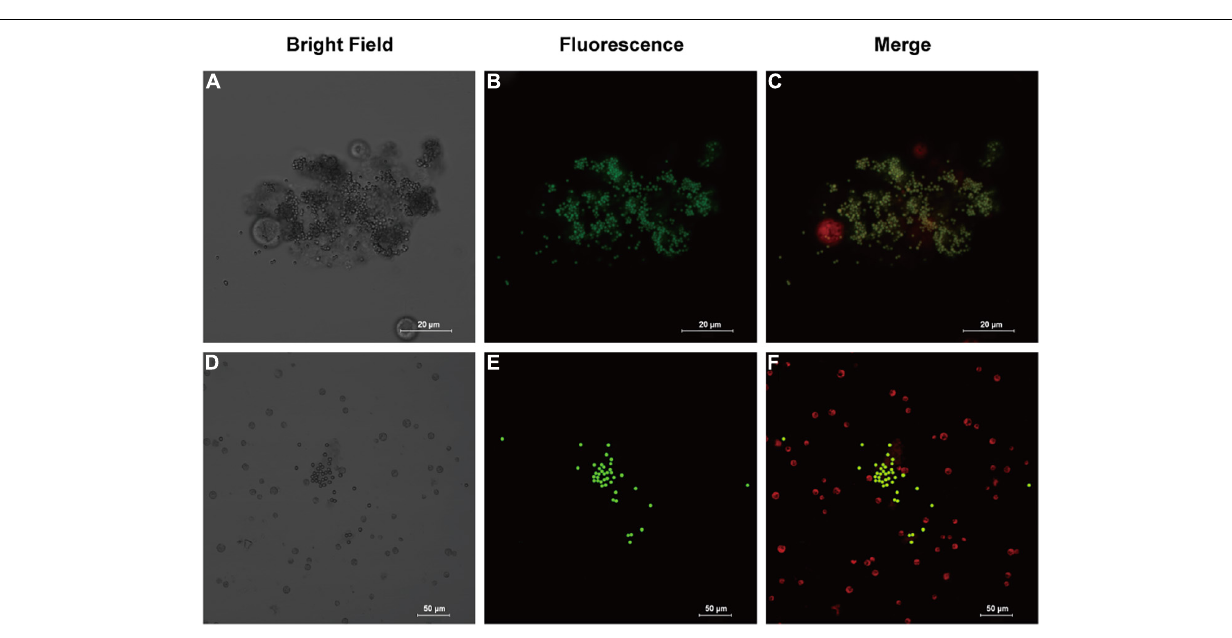
FIGURE 2 | Images of fluorescently labeled PS-MPs in microalgal culture (96 h). (A–C) : 1 µ m MPs in culture with Chlamydomonas reinhardtii ( C. reinhardtii ), bright field (A) the fluorescence of MPs distribution (B) and merged fluorescence of microalgae (red) and MPs (green) (C) . (D–F) : 5 µ m MPs in culture with C. reinhardtii , bright field (D) the fluorescence of MPs (E) and merged fluorescence (F)